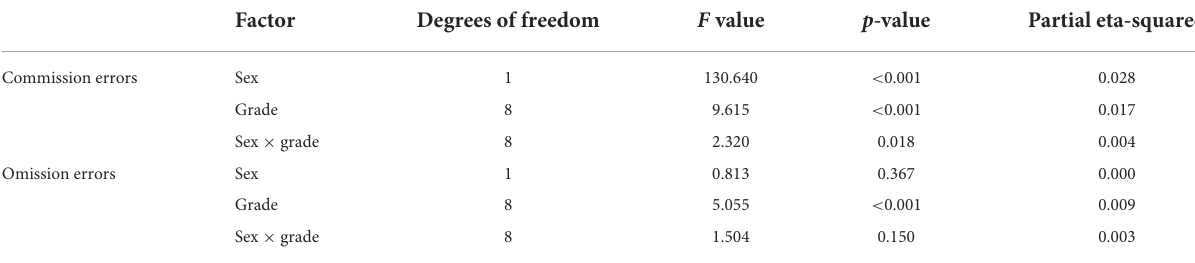
TABLE 2 Participants’ commission and omission errors by sex and grade.